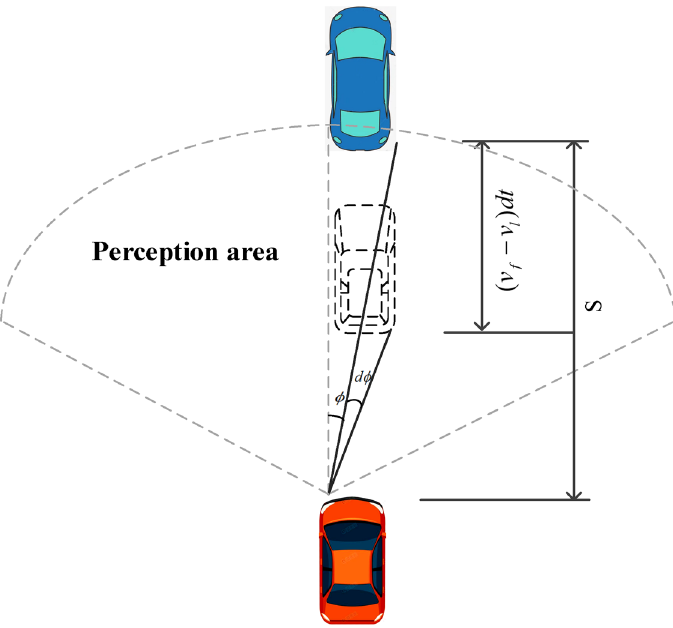
Figure 2. Relationship between driver’s viewpoint change and relative